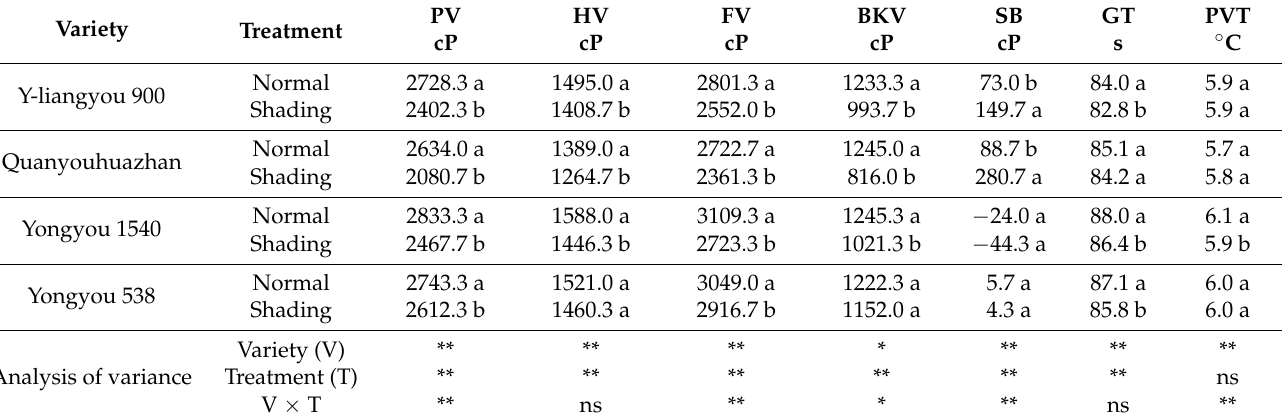
Table 6. RVA profile characteristics of different rice varieties under shading after flowering in